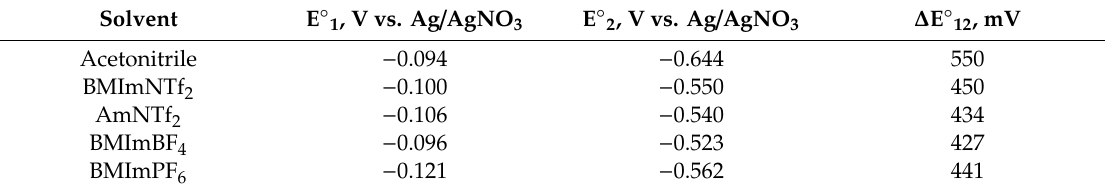
Figure 2. Cyclic voltammetry of TCNQ in acetonitrile (black trace) and in 20% AmNTf 2 / acetonitrile. Scan rate: 100 mV / s. Working electrode: platinum. Electrolyte: 0.10 M tetrabutylammonium perchlorate (TBAP). Table 1. Cyclic voltammetry of TCNQ in acetonitrile and several RTILs. Scan rate = 100 mV / s; working electrode was platinum. Electrolyte in acetonitrile: 0.10 M TBAP.